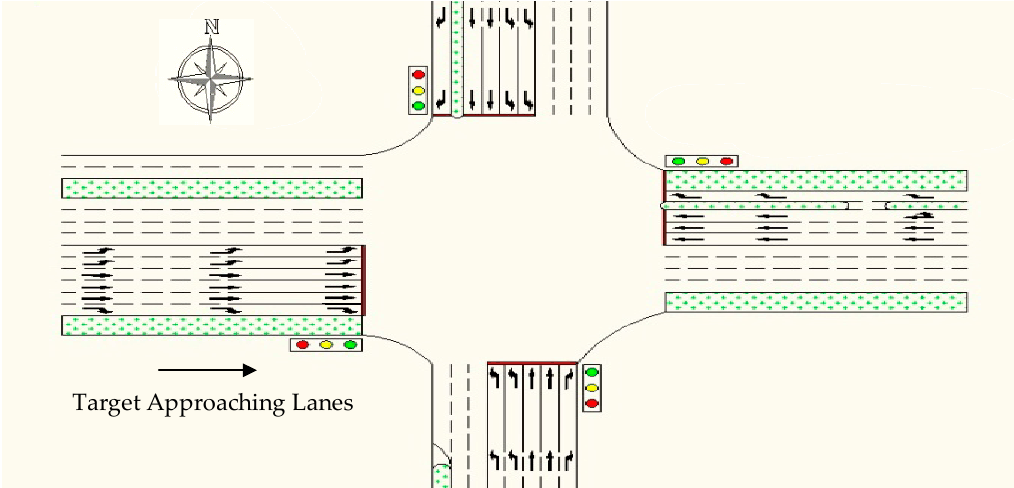
Figure 2. Graphical illustration of the intersection of Naoshikou Street and Xuanwumen West Street.